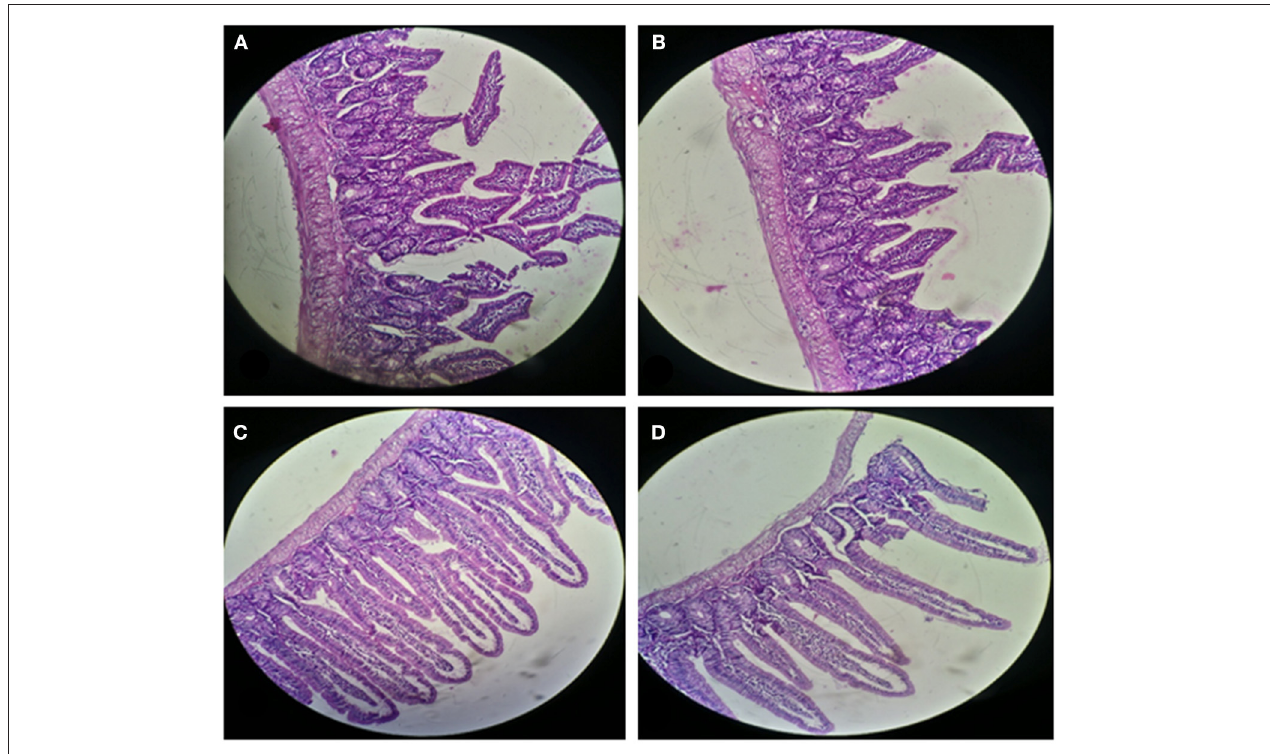
FIGURE 5 | Small Intestinal sections of mice at 20X microscope (A,B) negative control, (C,D) with Enterococcus mundtii QAUEM2808